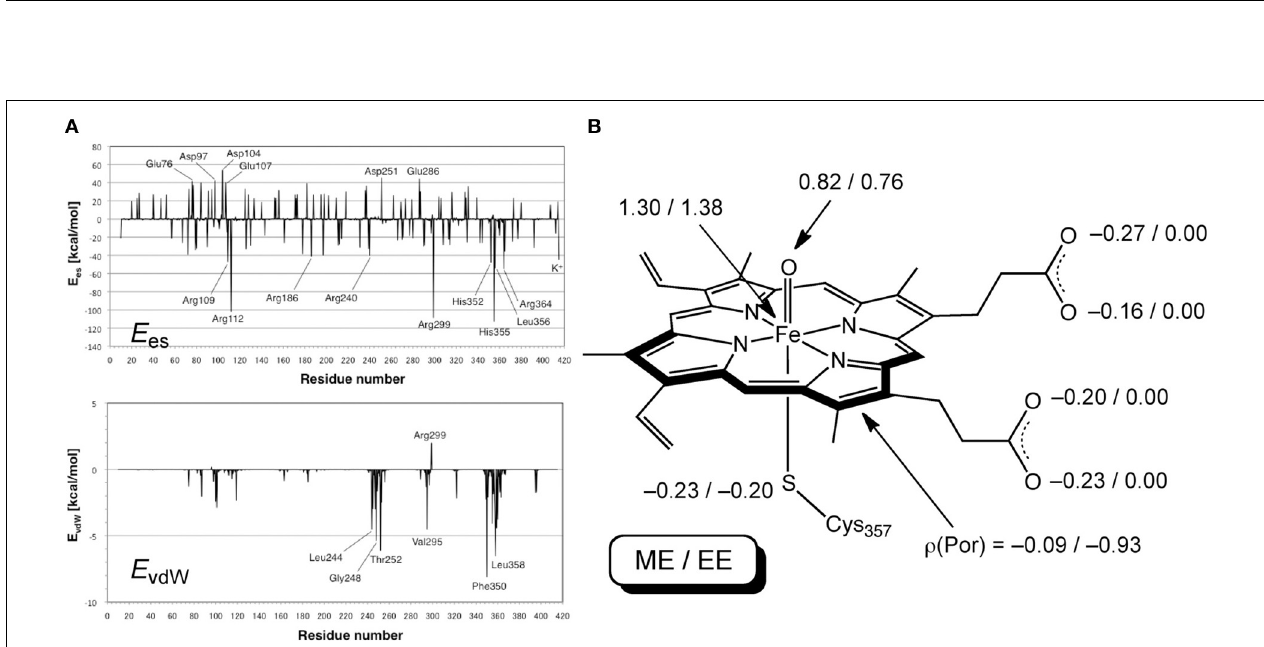
FIGURE 9 | Active site of P450cam Cpd I. Reprinted from Hirao (2011a) with permission from the Chemical Society of Japan.